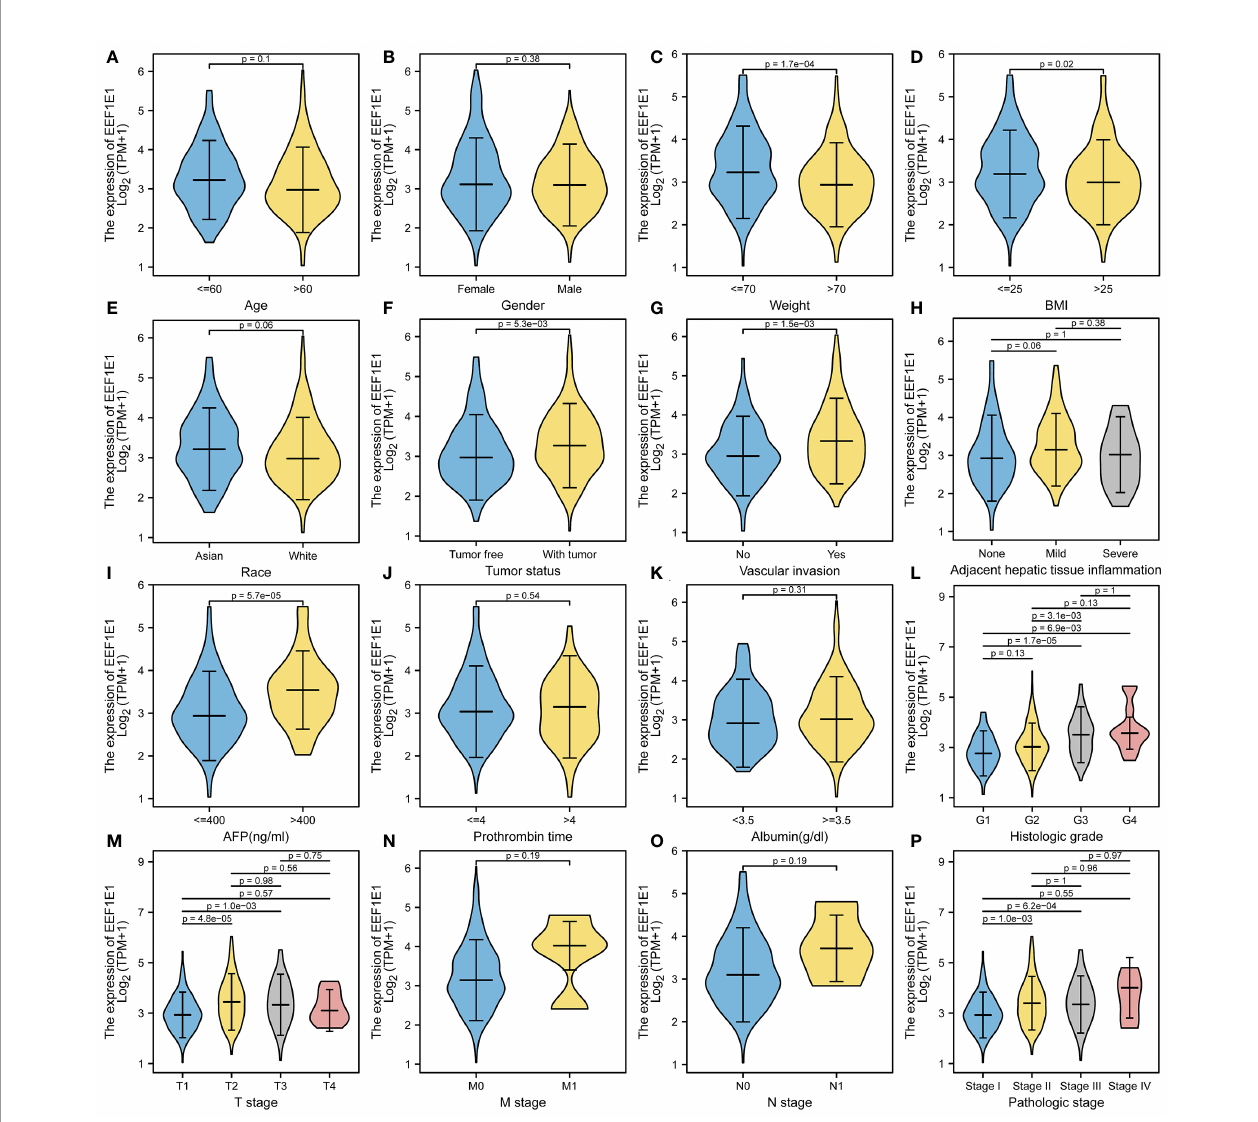
FIGURE 2 | Correlation between expression of EEF1E1 and clinic-pathological features. (A) Correlation between expression of EEF1E1 and age. (B) Correlation between expression of EEF1E1 and gender. (C) Correlation between expression of EEF1E1 and weight. (D) Correlation between expression of EEF1E1 and BMI. (E) Correlation between expression of EEF1E1 and race. (F) Correlation between expression of EEF1E1 and tumor status. (G) Correlation between expression of EEF1E1 and vascular invasion. (H) Correlation between expression of EEF1E1 and adjacent hepatic tissue in fl ammation. (I) Correlation between expression of EEF1E1 and AFP level. (J) Correlation between expression of EEF1E1 and prothrombin time. (K) Correlation between expression of EEF1E1 and Albumin level. (L) Correlation between expression of EEF1E1 and histologic grade. (M) Correlation between expression of EEF1E1 and T stage. (N) Correlation between expression of EEF1E1 and M stage. (O) Correlation between expression of EEF1E1 and N stage. (P) Correlation between expression of EEF1E1 and pathologic